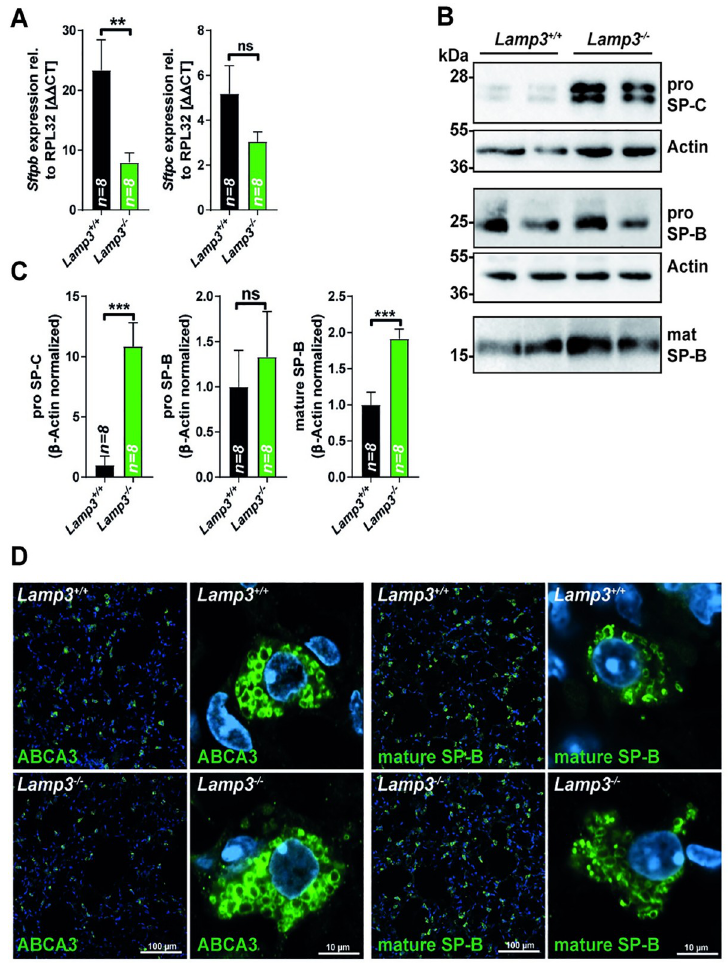
Fig 2. LAMP3-deficiency results in altered (pro-)surfactant C levels. (A) Quantitative real-time PCR of total RNA from wildtype and Lamp3 -/- mice for SP-B and SP-C. The expression was normalized to the housekeeping gene RPL32. n = 8 (per genotype), ns = not significant; �� = p � 0.01. (B) Representative immunoblots of lung tissue lysates from wildtype and Lamp3 -/- mice for pro-SP-C, pro-SP-B, and mature SP-B. Actin is depicted as a loading control. (C) Quantification of immunoblots for pro-SP-C, pro-SP-B, and mature SP-B normalized to Actin as a loading control. The average of the wildtype group was set as “1”. n = 8 (per genotype); ns = not significant; ��� = p � 0.001. (D) Immunofluorescence staining of lung sections from adult wildtype and Lamp3 -/- mice for ABCA3 and mature SP-B (green). Nuclei are stained with DAPI (blue).